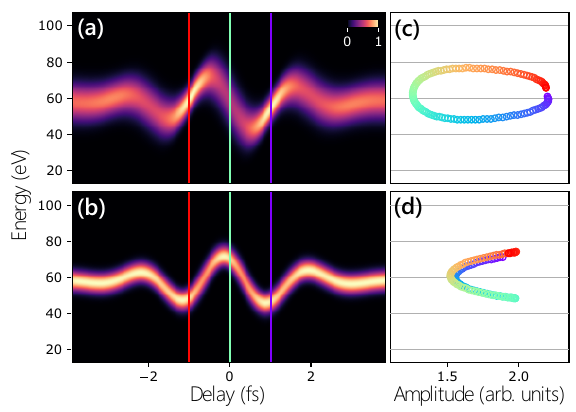
Figure 2. (a,b) Simulated attosecond streaking traces, with a 3 × 10 2 fs − 2 atto-chirp (a), and with a null atto-chirp (b). (c,d) Corresponding correlation graphs between the mean energy (ver- tical axis) and the amplitude at this energy (horizontal axis), for delays varying between the red and blue vertical lines in (a,b). The delay is increasing from red to blue, and the horizontal axis of (c) and (d) have the same